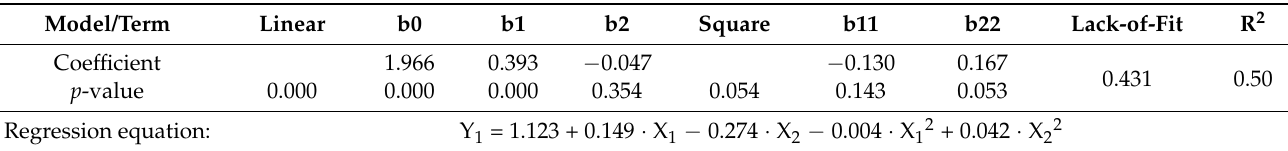
Table 1. Coded coefficients of the response surface regression of thickness (Y 1 ) performed on the factorial design with 5 levels and regression equation in uncoded